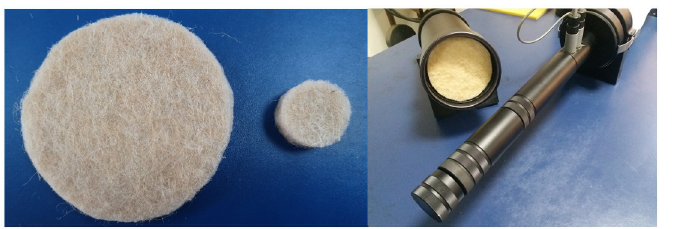
Fig 4. Jute fiber felt samples and the impedance tube installed with a